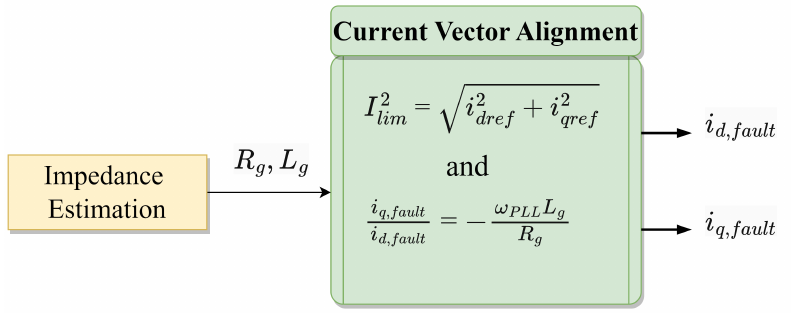
Figure 11. Current vector alignment for a stable operating area [90].